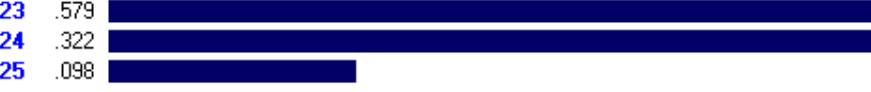
Fig. 10. The evaluation for category D parts.